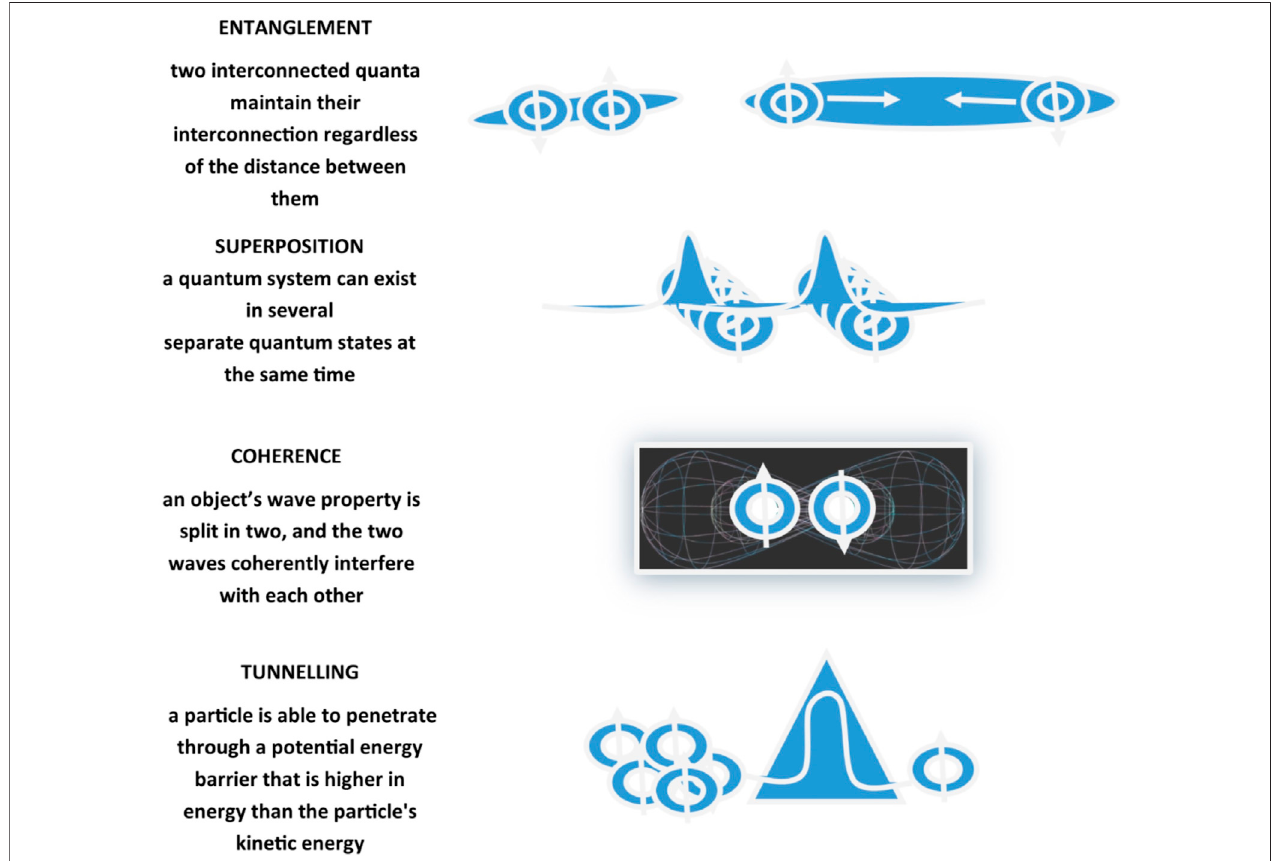
FIGURE 2 | Schematic representation of quantum mechanical effects including entanglement, coherence, superposition, and tunneling. Entanglement, also de fi nedasquantumcorrelation,istheabilityoftwoquantainterconnectedwitheachothertomaintaintheinterconnectionregardlessofthedistancethatseparatesthem. Coherencereferstotheabilityofaquantumstatetomaintainitsentanglementandsuperpositiondespiteinteractions.Superpositionistheabilityofaquantumsystemto be in multiple states at the same time until it is measured. Tunneling is a quantum mechanical phenomenon related to the behavior of a quantum particle at a potential barrier through which a wave function can propagate even though particle total energy is less than the barrier height.